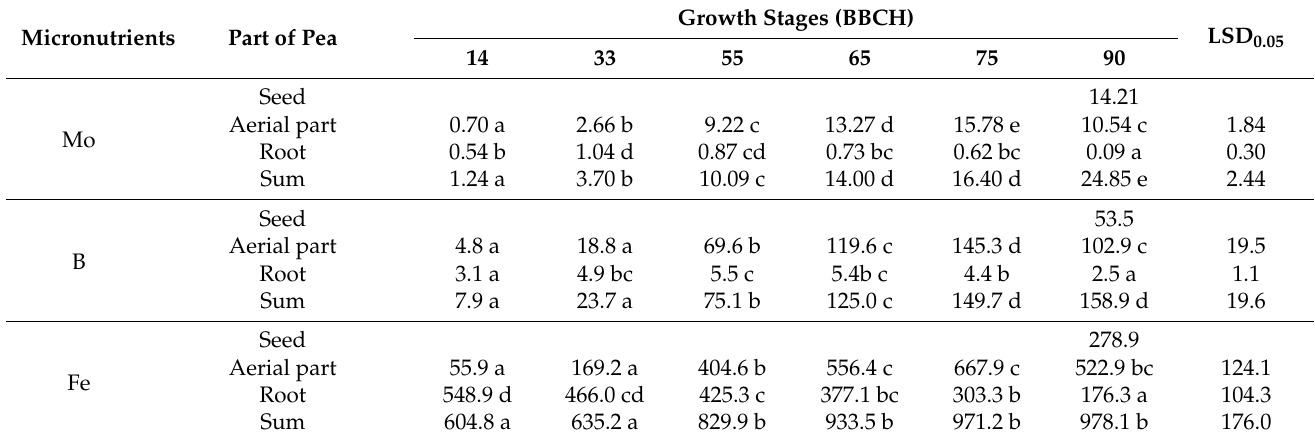
Table 5. Mo, B, Fe uptake by pea in successive growth stages, g · ha –1